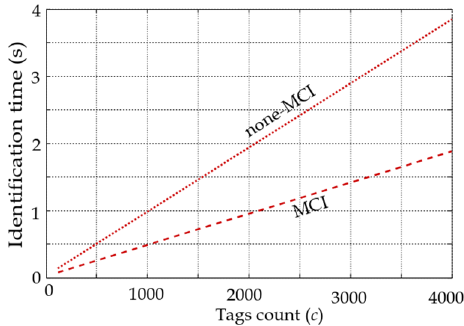
Figure 11. Average identification time for different tag population in the standardized Q-Algorithm.